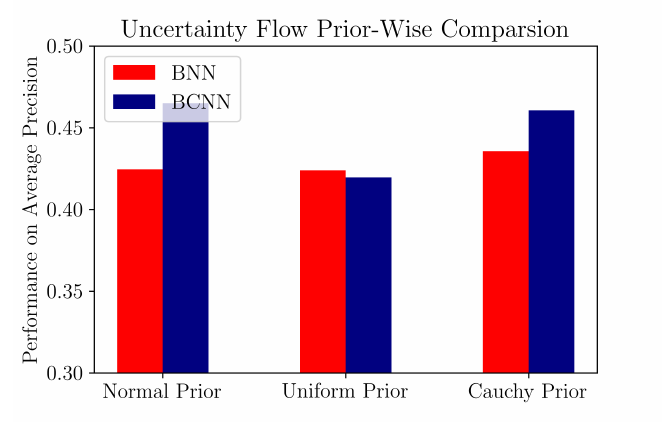
Figure 7. Prior Induced Discriminability Differences in Uncertainty Flow . Note here, we rule out the impacts of uncertainty indexes via averaging the performance of models with same implemented prior. Average precision is chosen as other metrics failed to render clear discriminability